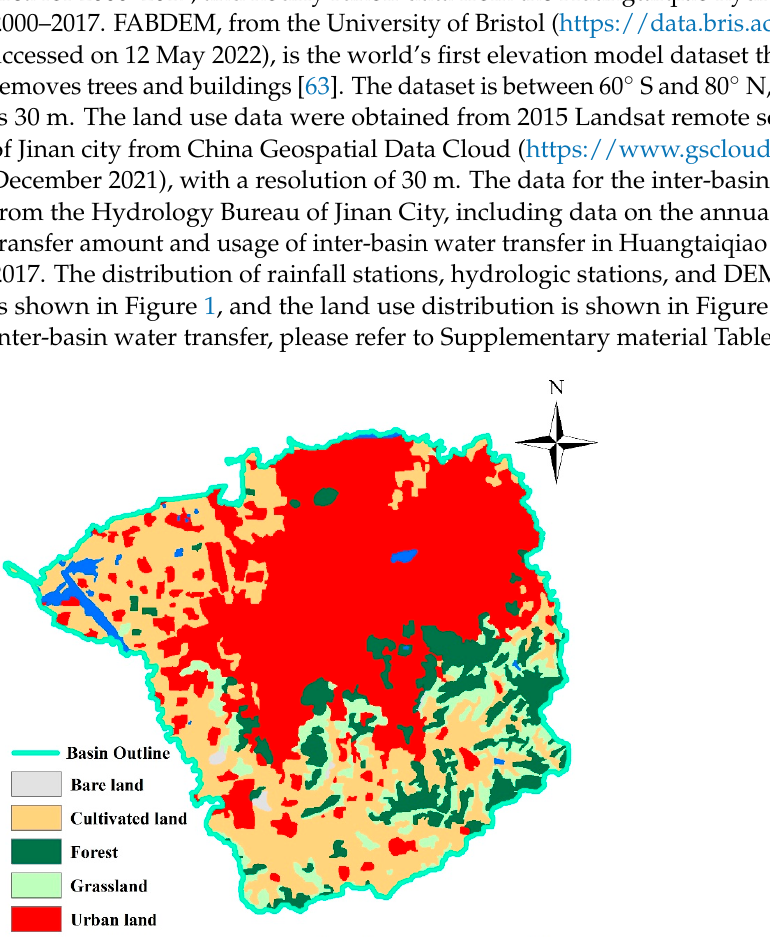
Figure 2. Land use of the Huangtaiqiao basin .